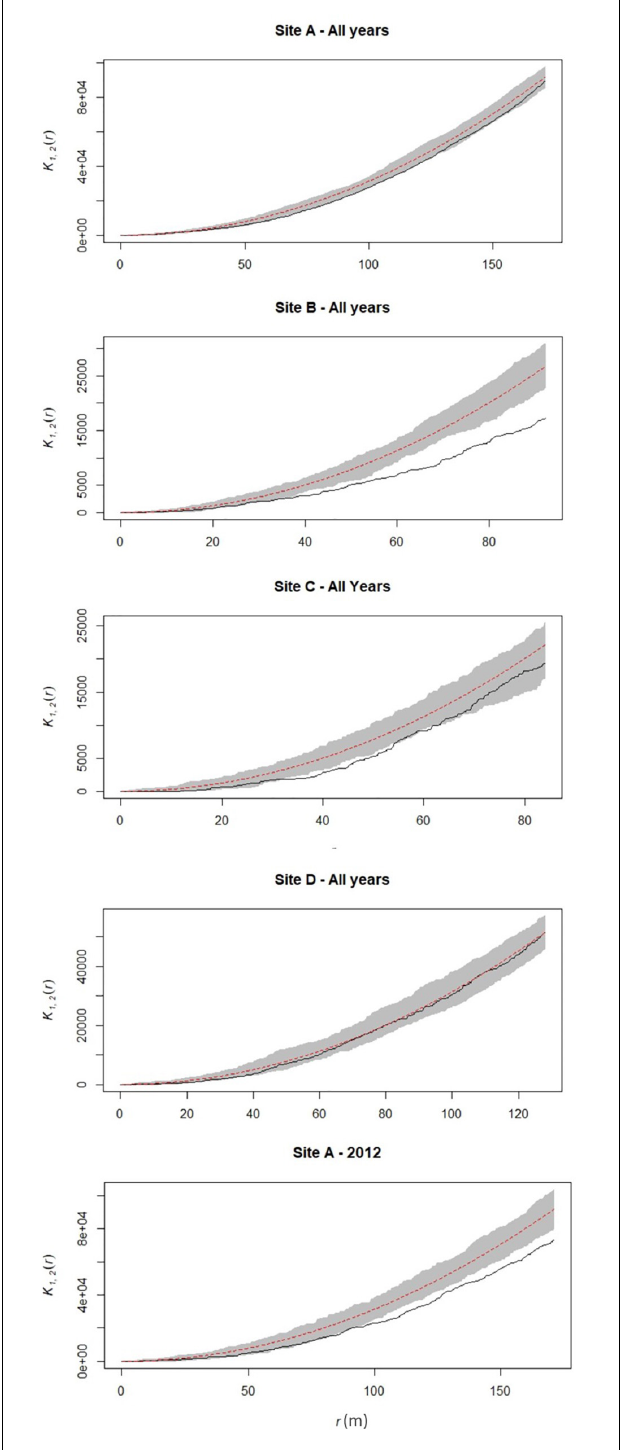
FIGURE 2 | Spatial aggregation between the Eastern Chipmunk locations and the Hermit Thrush and Ovenbird nests. The gray 99% confidence envelope and red line indicate the null hypothesis of complete spatial randomness (CSR). The black line indicates the observed Bivariate Ripley K values against Euclidean distance r . When the black line is below the confidence envelope, it indicates a significant negative spatial aggregated